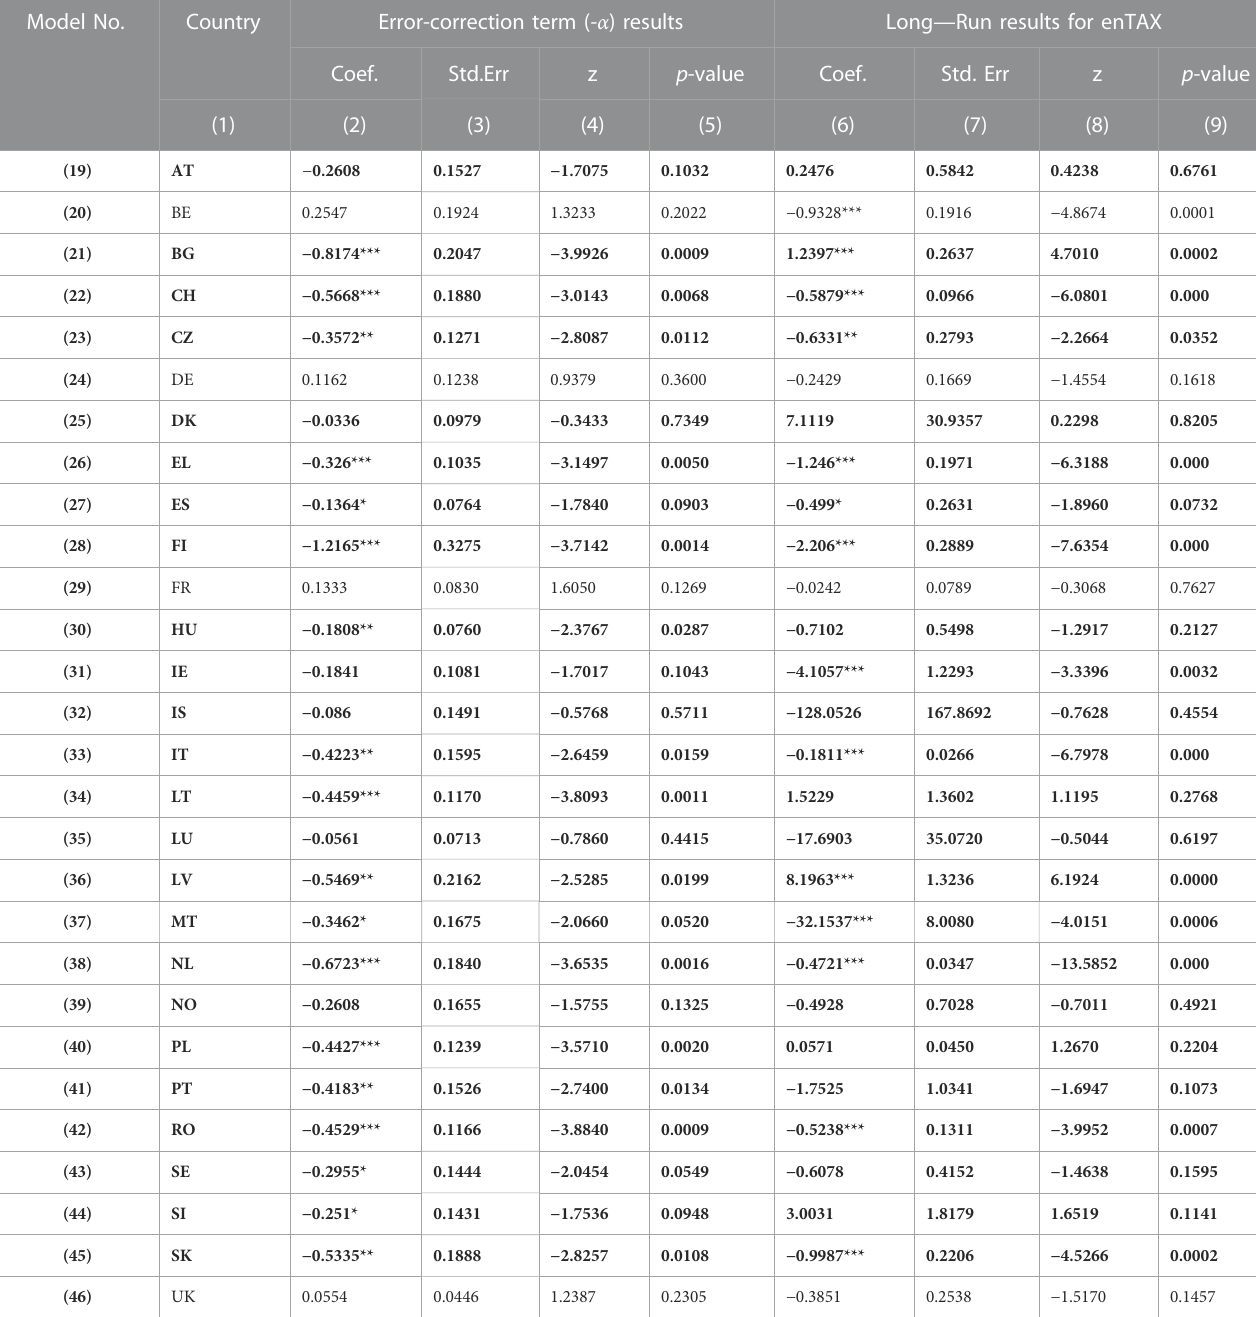
TABLE 6 ARDL model results at country level. Model No.